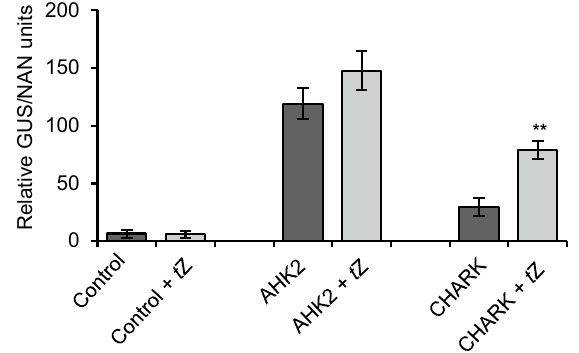
Figure 4. Cytokinin receptor assay in ahk2 ahk3 receptor mutant protoplasts. Mesophyll protoplasts of A. thaliana receptor mutant line ahk2-5 ahk3-7 were co-transfected with the pARR6:GUS reporter gene, 35S:ARR2 and 35S:CHARK or 35S:AHK2 (positive control) or the empty vector (negative control) 36 . For cytokinin treatment, the protoplasts were incubated overnight with 500 nM trans -zeatin ( t Z). Data represent mean values of three biological replicates ± SD. Student’s t -test was used to calculate the significance of differences between untreated samples and cytokinin-treated samples. ** P < 0.